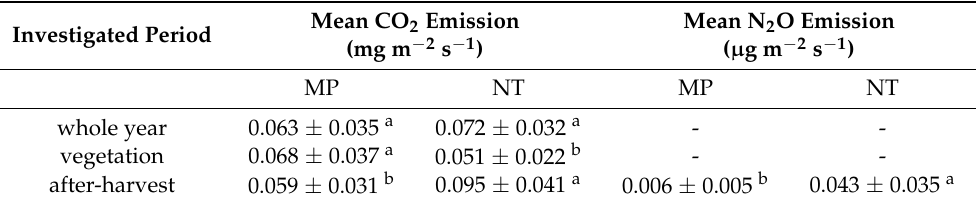
Table 11. Mean values of GHG emissions divided into different periods.